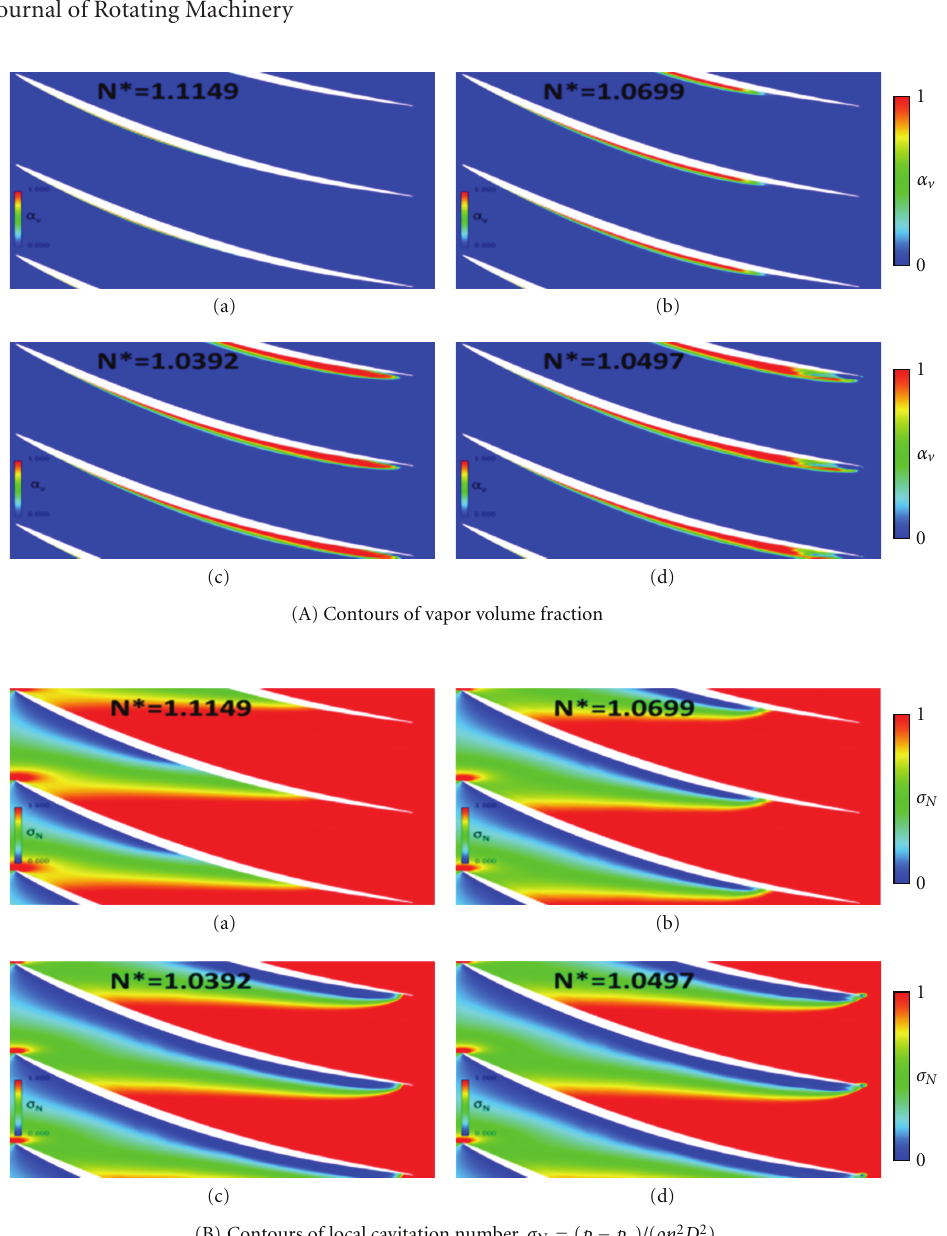
Figure 10: Computational results, constant radius cut through rotor solution, r/R shroud = 0 . 698 (near mid span), Q ∗ = 0 . 825. Results at each of four conditions, (a) ( N ∗ = 1 . 1149) (b) ( N ∗ = 1 . 0699) (c) ( N ∗ = 1 . 0392) (d) ( N ∗ = 1 . 0497), prior to and after breakdown. (A) Vapor volume fraction contours. (B) Local cavitation